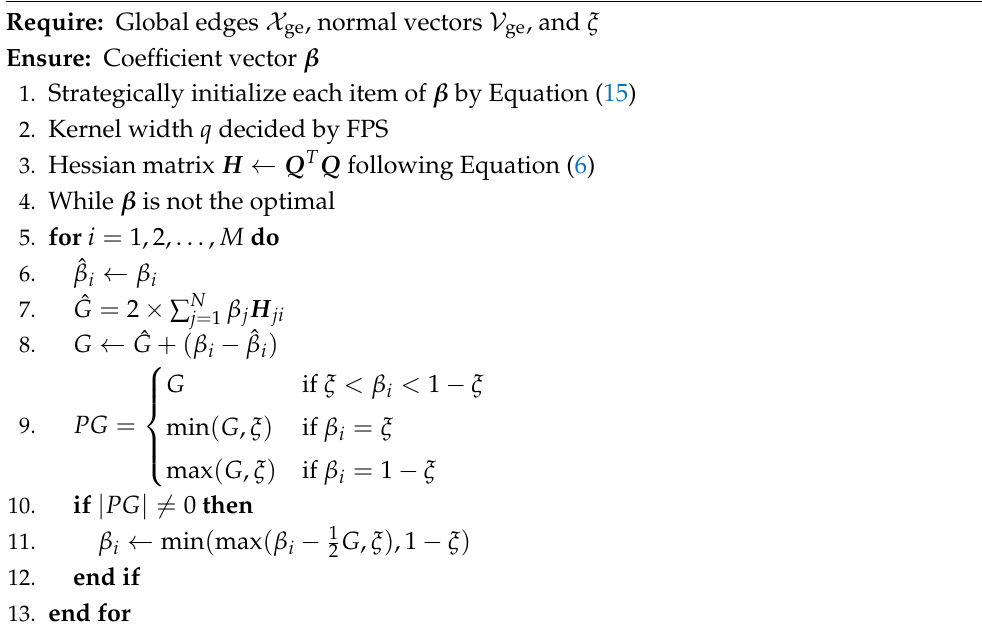
Algorithm 3 iSolver for the Dual Problem